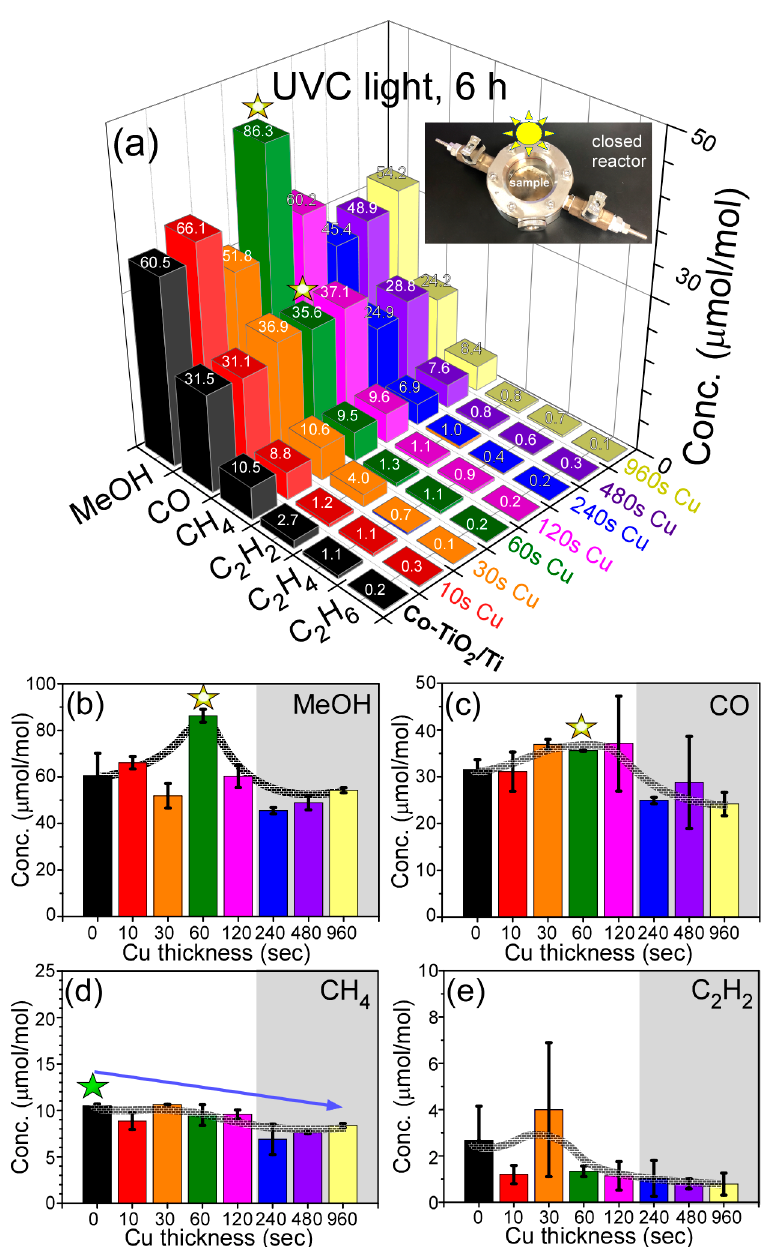
Figure 7. Photocatalytic CO 2 reduction yields: ( a ) for bare Co-TiO 2 /Ti and 10s, 60 s, 120 s, 240 s, 480 s and 960 s-Cu-deposited Co-TiO 2 /Ti samples, and MeOH ( b ), CO ( c ), CH 4 and ( d ) C 2 H 2 ( e ) yields ( µ mol/mol) with error bars. Photo is a closed stainless reactor with a Co-TiO 2 /Ti disc inside. The asterisk indicates the maximum point.